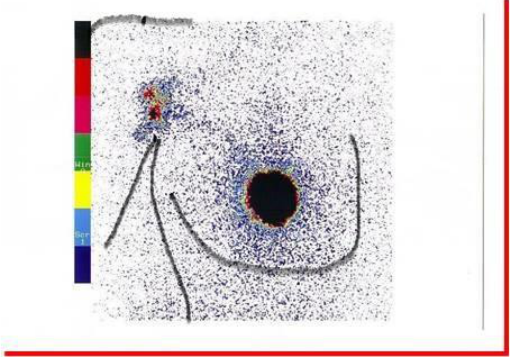
Figure 3. Left Anterior Oblique 45° sentinel node lymphoscintigraphy. Figure 3. Right Anterior Oblique 45 ◦ sentinel node